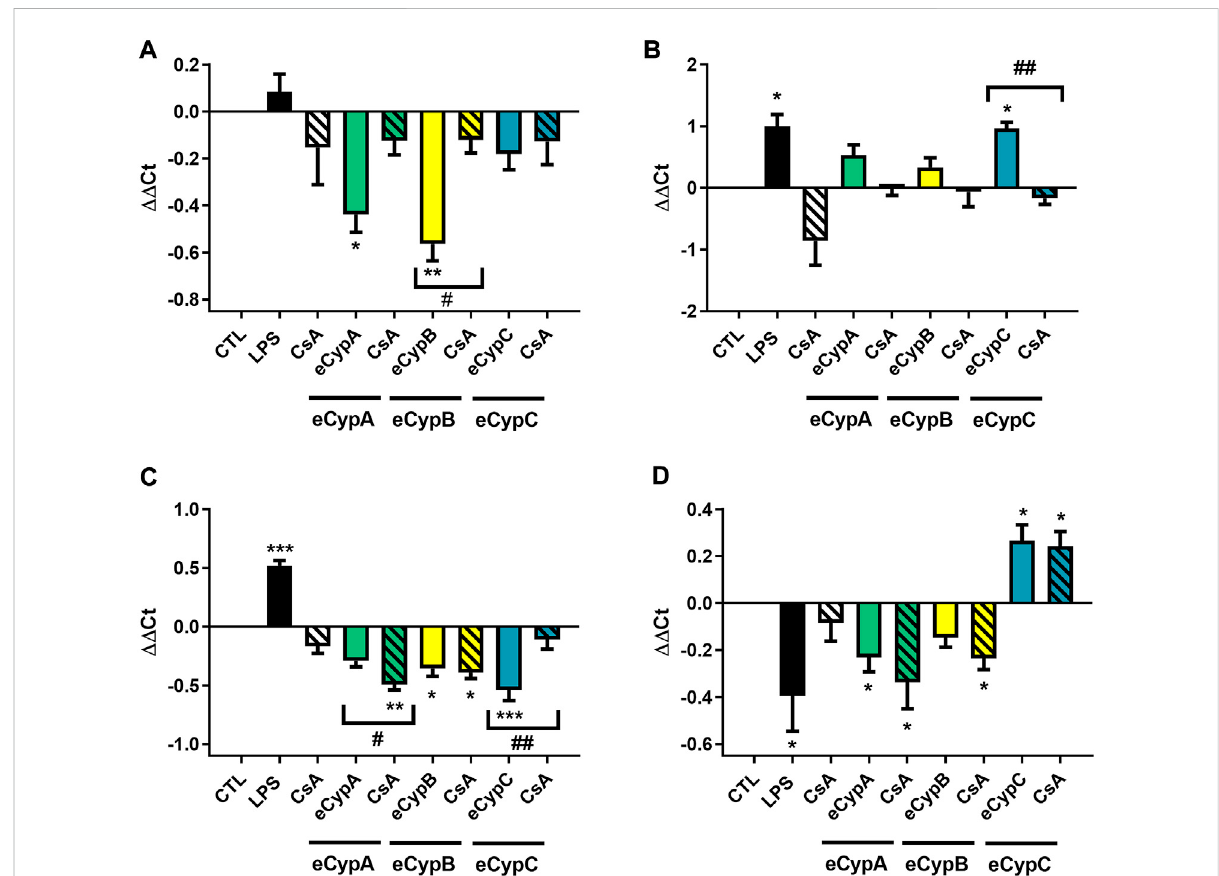
FIGURE 6 GeneexpressionofCypsinpresenceofeCyps A,Band C.Relative geneexpressionof (A) CypA , (B) CypB , (C) CypC , and (D) CypD after addition ofeCypsA,BandCat0.5 μ g/mlfor24 h.CsAat0.2 μ Mwasadded1 hbeforetreatmentandLPS(1 μ g/ml)wasusedaspositivecontrol.Relativegene expressionwascalculatedwith ΔΔ Ctmethod.Controlcellswereusedascalibratorand GAPDH asinternalnormalizationcontrol.Dataareexpressed as mean ± SEM of three independent replicates performed by triplicate. Statistical signi fi cance evaluated by one way ANOVA and Tukey ’ s